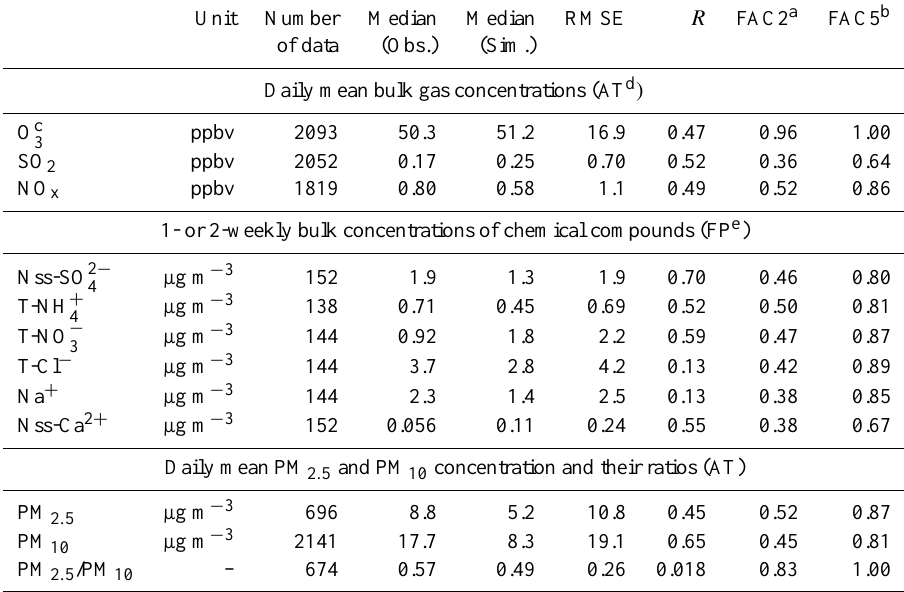
Table 5. Statistical analysis for comparing all EANET observation and simulation data for 2006.